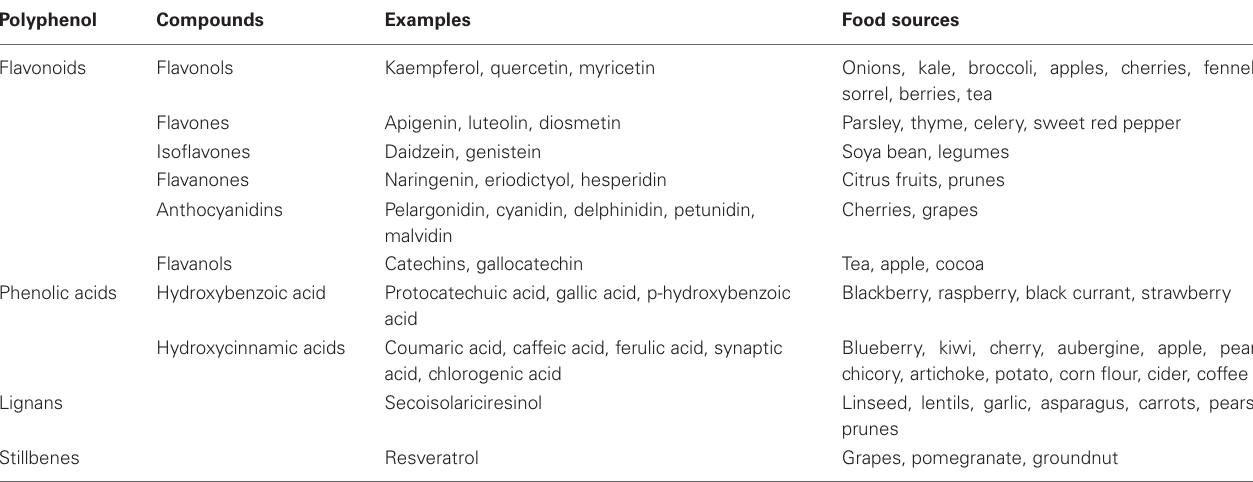
Table 2 | Polyphenols in